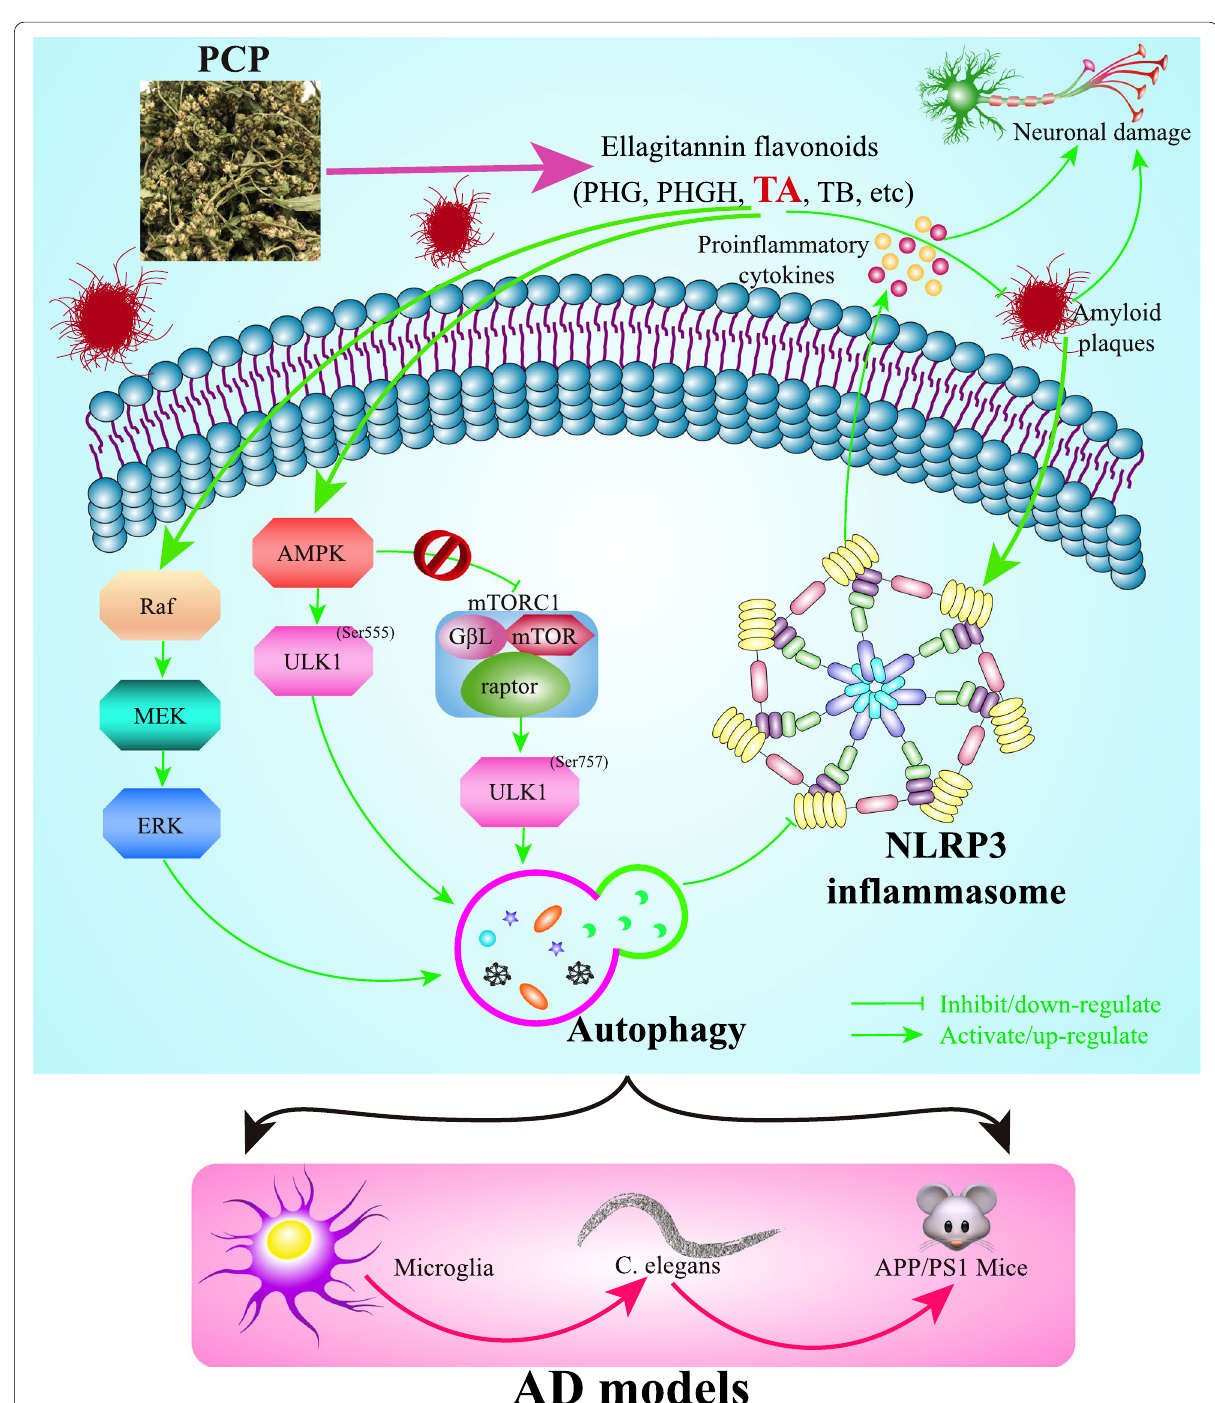
Fig. 9 The schematic diagram depicts that TA, one of the ellagitannin flavonoids derived from PCP, inhibits the activation of the NLRP3 inflammasome via the AMPK/ULK1‑ and Raf/MEK/ERK‑mediated autophagy in the in vitro and in vivo models of AD, including microglia, C. elegans , and APP/PS1